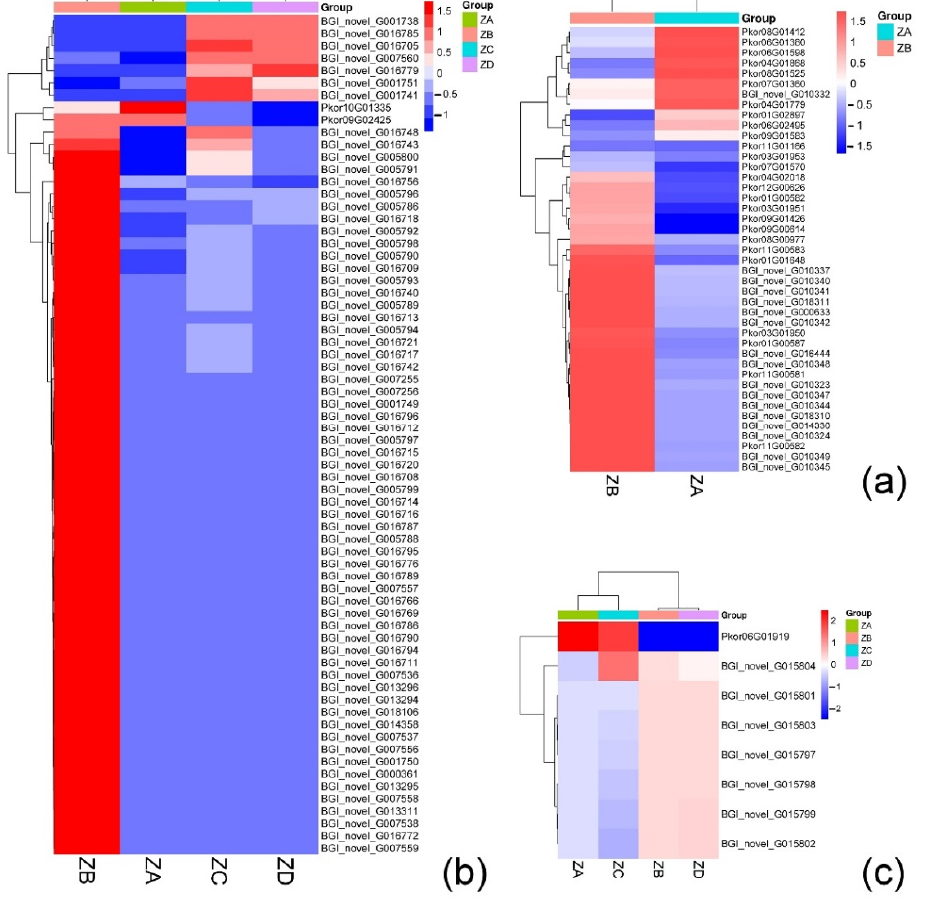
Figure 7. ( a ) Expression of differential genes related to heat shock proteins before and after fertili- zation of Korean pine; ( b ) Expression of differential genes related to SKP1 in Korean pine before and after fertilization; ( c ) Expression of RBX1-related differential genes in Korean pine before and after fertilization.